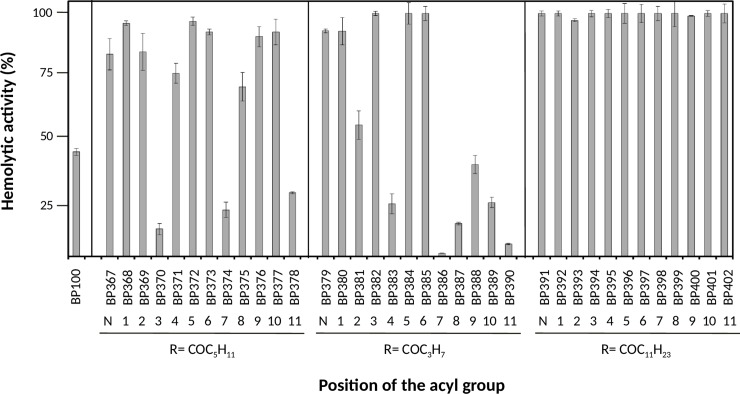
Hemolytic activity of the lipopeptides derived from BP100 at 250 μM.Vertical bars within each column indicate confidence interval at the mean. The position of the acyl group at the N-terminus is indicated by a N, and the position of the acylated Lys by numbers 1 to 11. The type of the acyl group is depicted as R = COC5H11 (hexanoyl), R = COC3H7 (butanoyl) and R = COC11H23 (lauroyl).